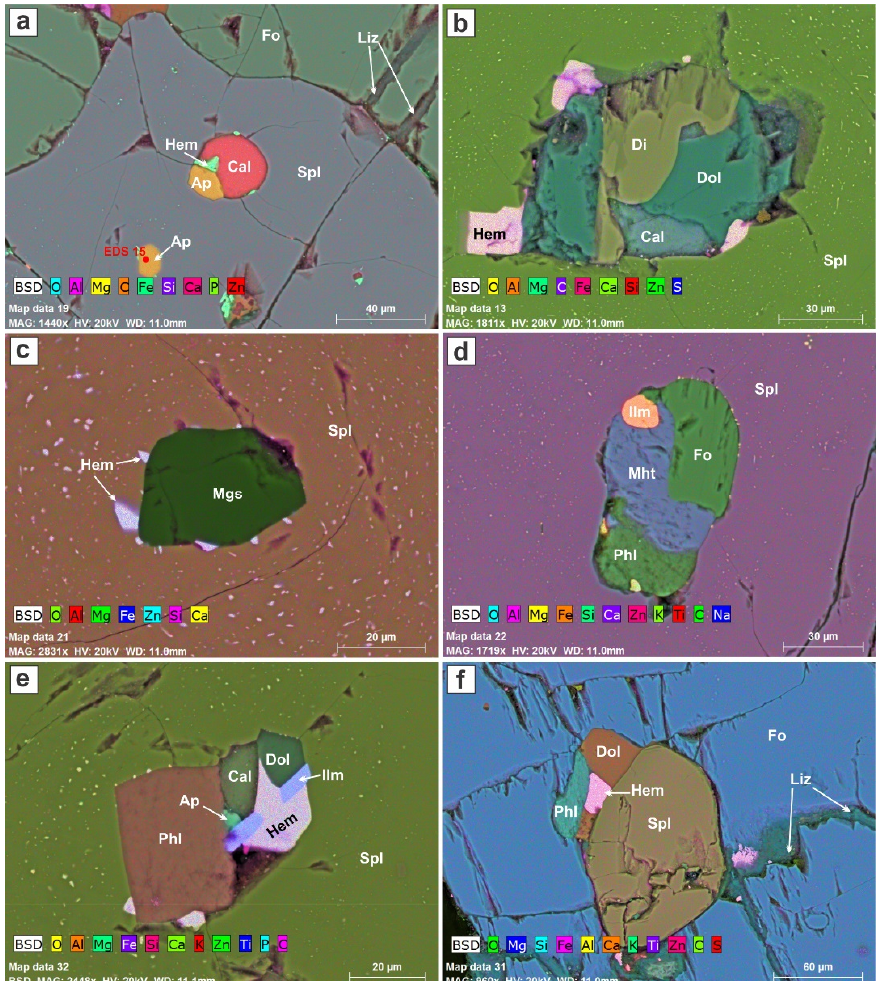
Figure 6. False-color EDS element-distribution maps of polymineralic micro-inclusions found in the spinel and forsterite crystals in the dunite. ( a ) Globular inclusion containing calcite, hematite and apatite. ( b ) Inclusion containing diopside, dolomite, calcite, and hematite. ( c ) Inclusion of magnesite decorated with hematite crystallites. ( d ) Inclusion containing forsterite, ilmenite, magnesio-hastingsite, and phlogopite. ( e ) Inclusion with phlogopite, calcite, dolomite, hematite, ilmenite, and apatite. ( f ) polymineralic inclusion in forsterite containing spinel, hematite, dolomite, and phlogopite. EDS point analysis 15 is shown in Figure S5.